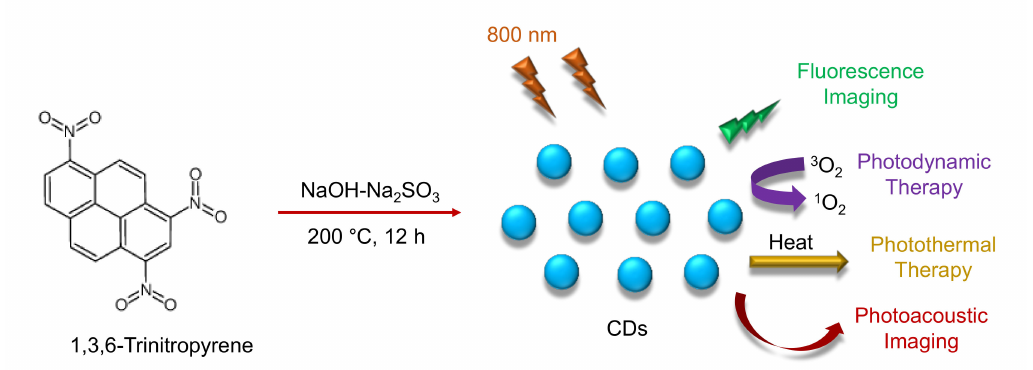
Figure 31. Preparation of TNP-derived CDs, and their versatile role in bioimaging and therapy development. Adapted from [345], with permission from John Wiley and Sons,